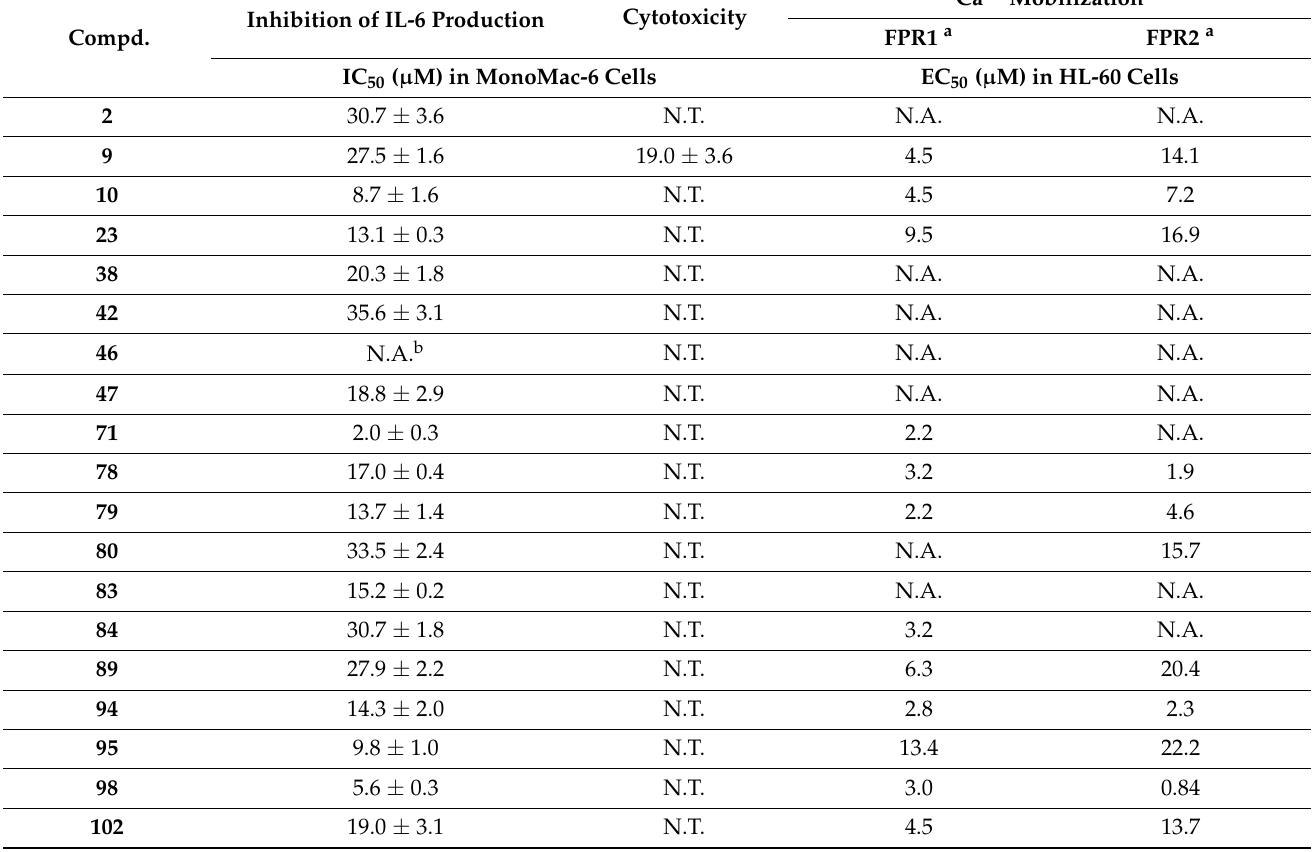
Table 3. The effects of selected compounds and FPR peptide agonists on the LPS-induced production of IL-6 in human MonoMac-6 cells, cytotoxicity, and Ca 2+ mobilization in FPR1/FPR2-transfected HL-60